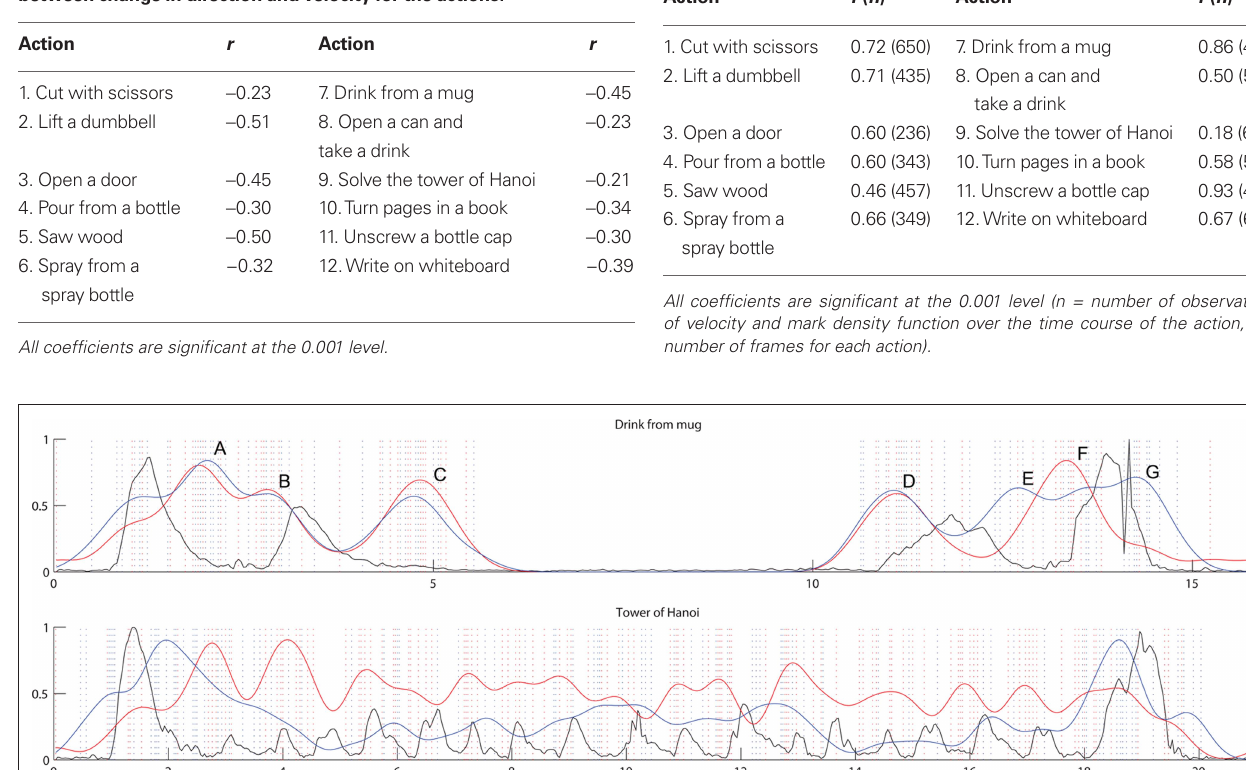
Table 5 | Correlation coefficients (Pearson r ) for the relationship between change in direction and velocity for the actions.